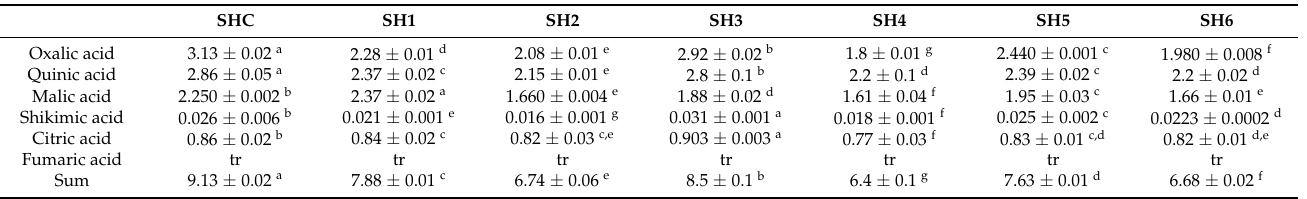
Table 4. Organic acids (mg/100 g dw) content in S. hispanicus leaves in relation to fertigation regime (mean ± SD).